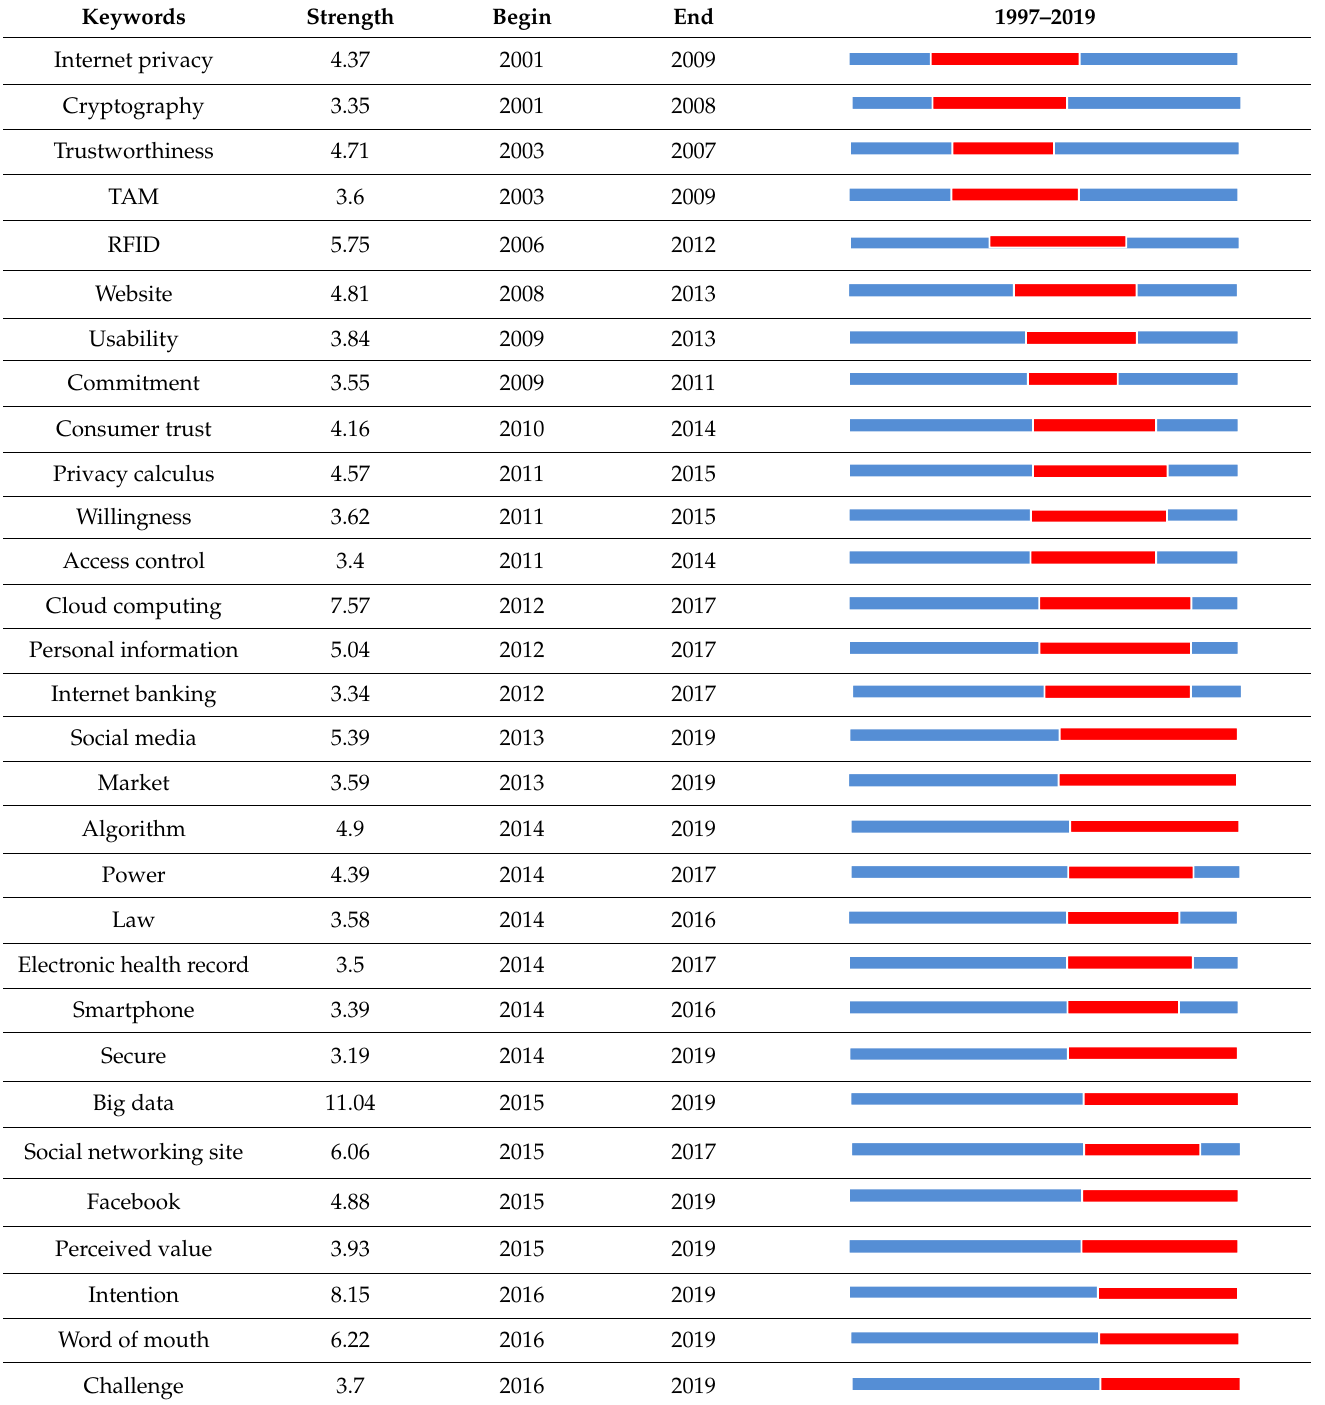
Table 2. Summary of the top 30 keywords based on citation burst strength.